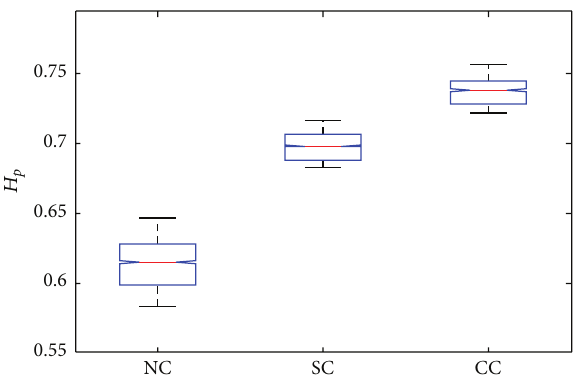
Figure 4: Boxplot of PE values on normal condition (NC), slight fault condition (SC), and catastrophe fault condition (CC).